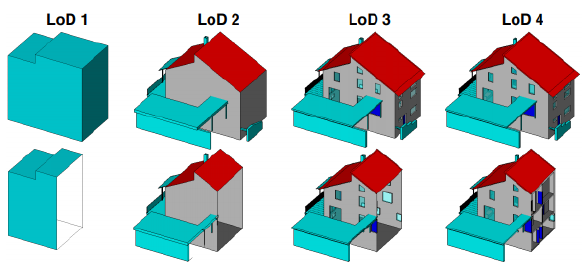
Figure 1. Four LoDs of CityGML (Courtesy of Karlsruhe Institute of Technology) (Biljecki,